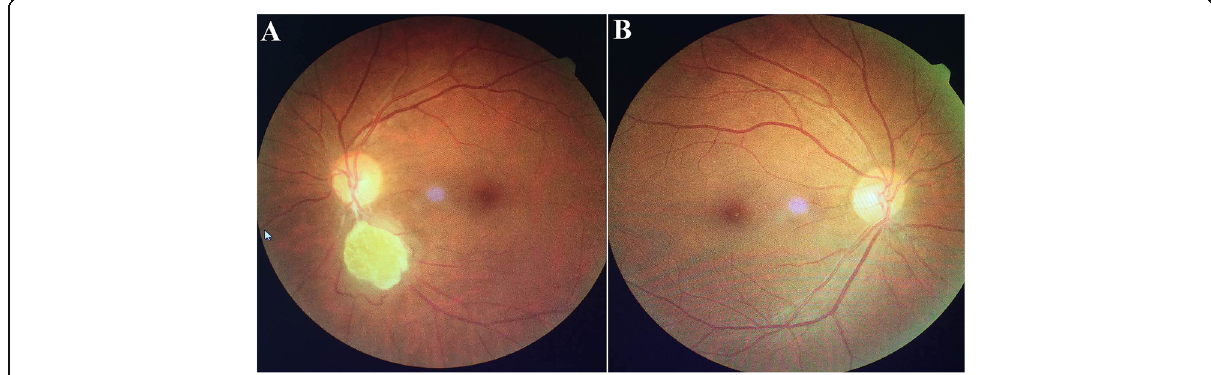
Fig. 4 Fundus Photograph of the proband Ib. a . Left eye, Fundus photograph of a hamartoma with central calcifications and a surrounding translucent zone. b . Right